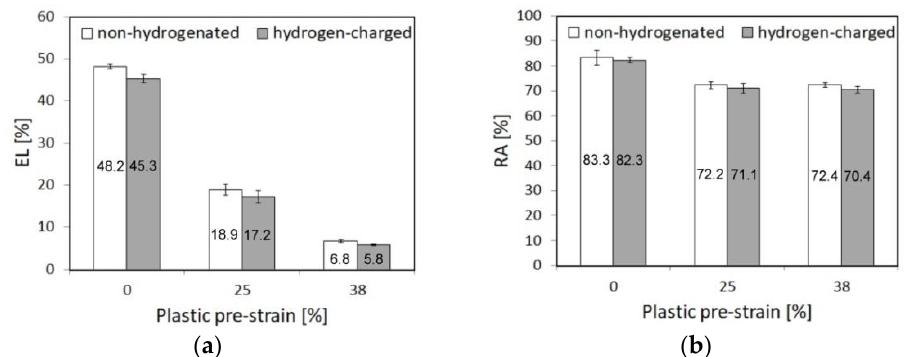
Figure 9. The effects of plastic pre-straining and subsequent electrochemical hydrogen charging of 316H steel on its deformation properties: ( a ) total elongation; ( b ) reduction of area.